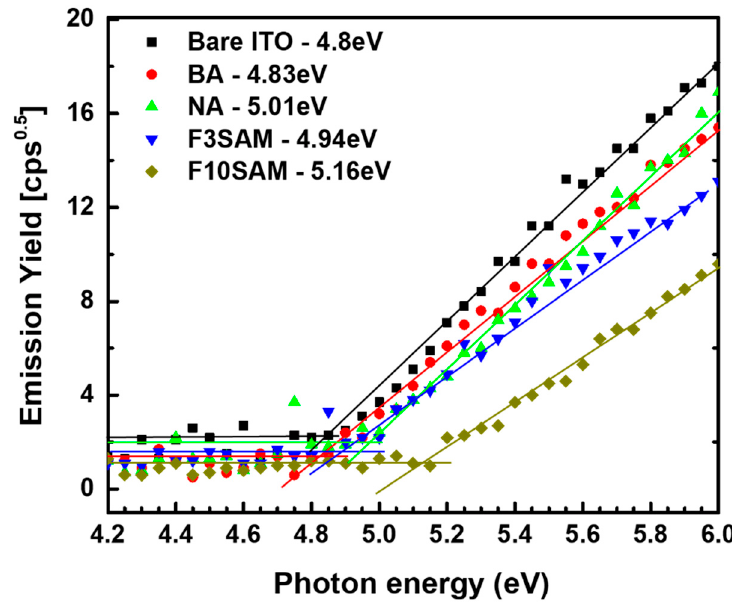
Figure 6. Work function of BA, NA, F-3SAM, and F-10SAM.